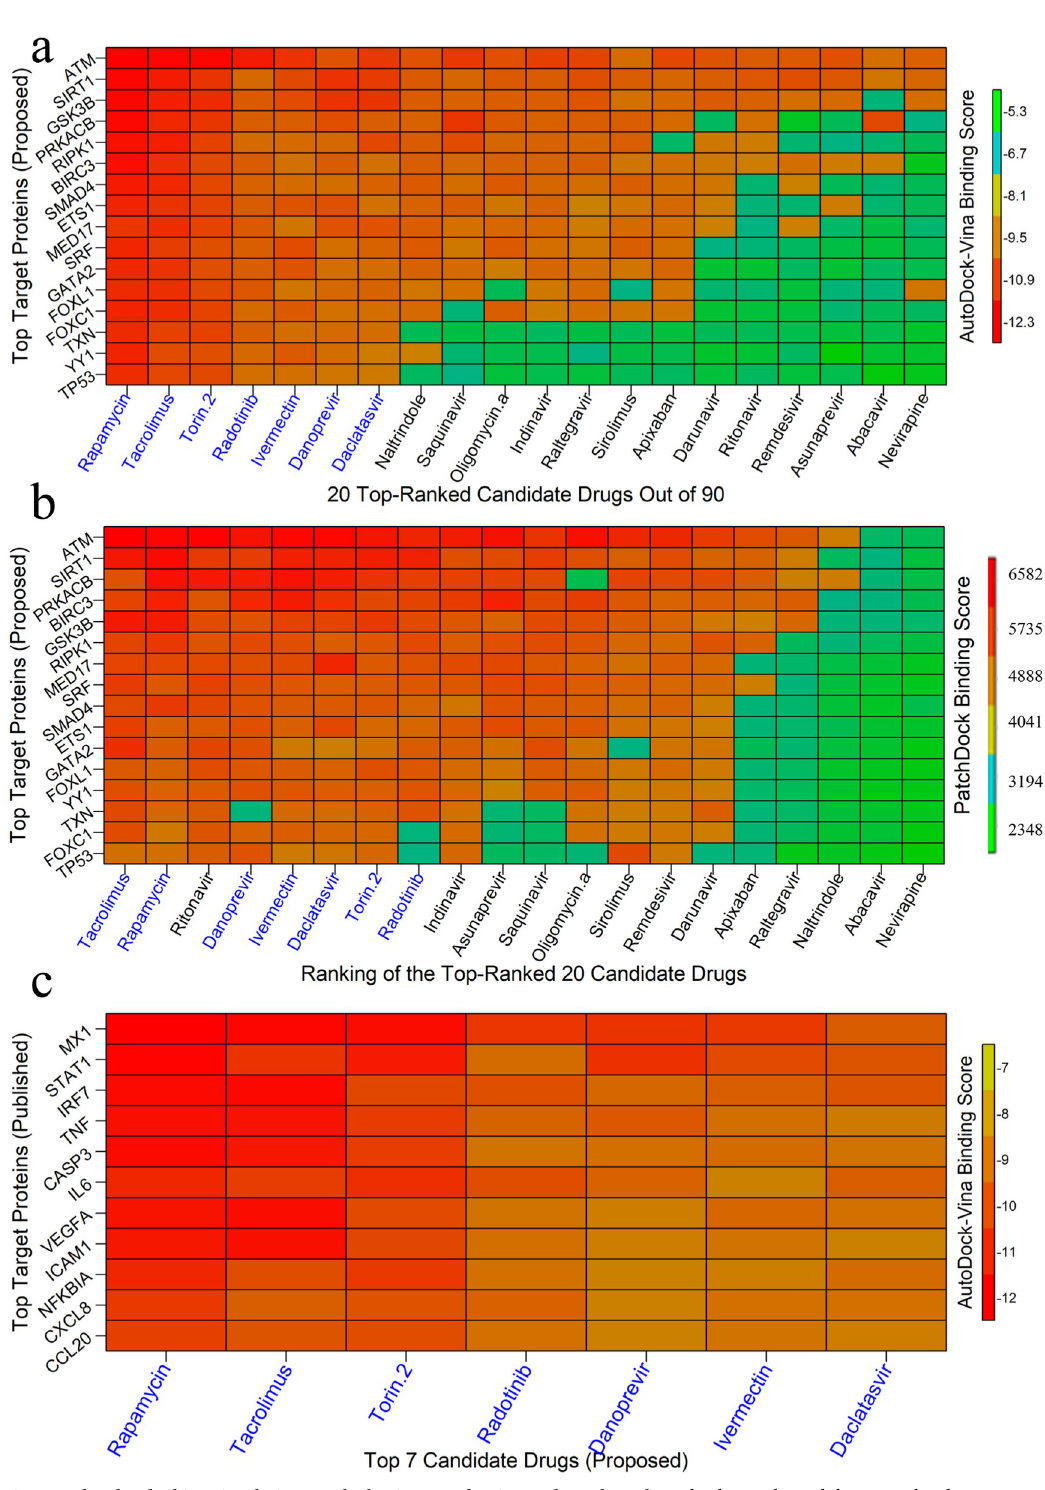
Fig 8. Molecular docking simulation results by AutoDock-Vina and PatchDock. Red colors indicated the strong binding affinities between target proteins and drug agents, and green colors indicated their weak bindings. (a) Image of binding affinity scores (computed by AutoDock-Vina) based on the top listed ordered 90 anti-viral drug agents in X-axis and ordered 17 target proteins (proposed) corresponding to SARS-CoV-1 in Y-axis. (b) Image of binding scores (computed by PatchDock) based on the ordered top-ranked 20 anti-viral drug agents (from 7a) in X-axis and ordered 17 target proteins corresponding to SARS-CoV-1